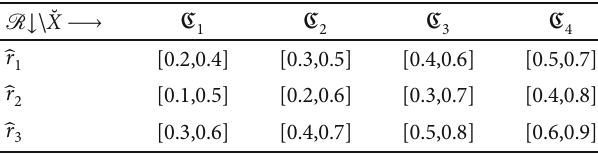
Table 5: An upward directed interval-valued fuzzy hypersoft set ð , R Þ Ψ FHS